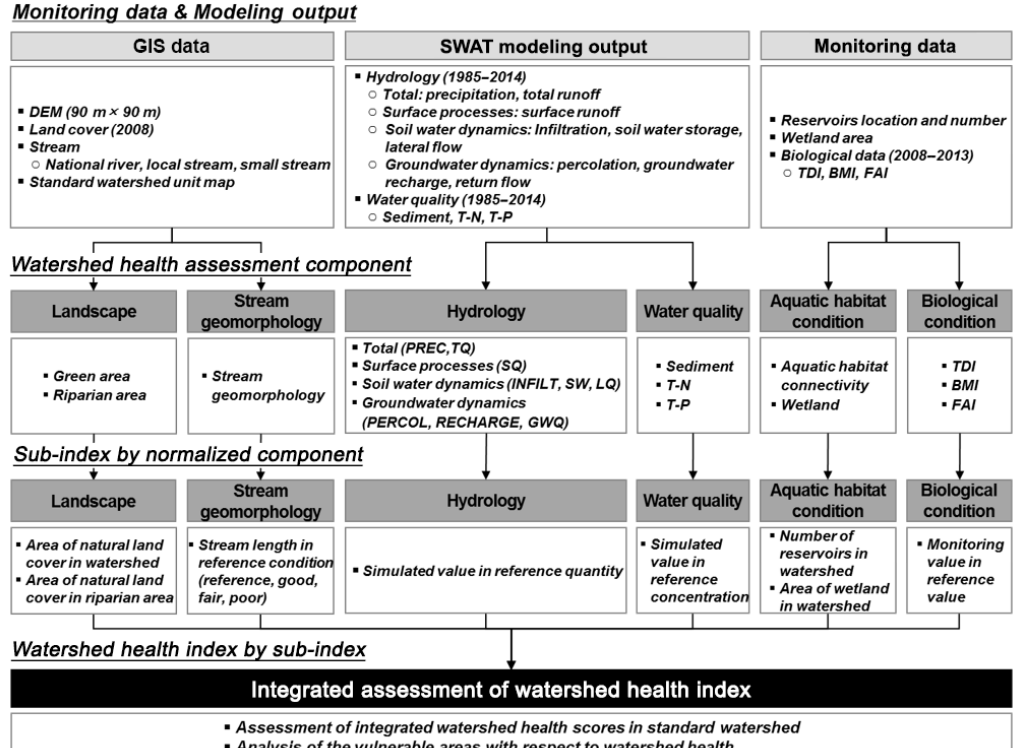
Figure 1. Flowchart of the study procedure for the watershed-health